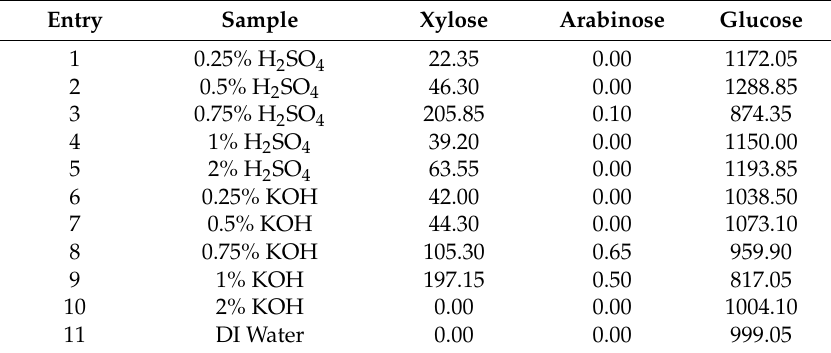
Table 4. Analysis of corncob solid residue after catalysis